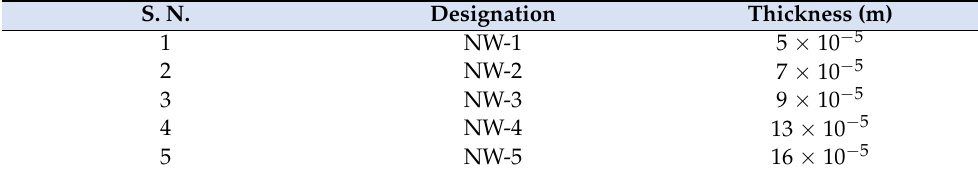
Table 2. Detailed specifications of non-woven ventilation cloths of irregular meshes. S. N.